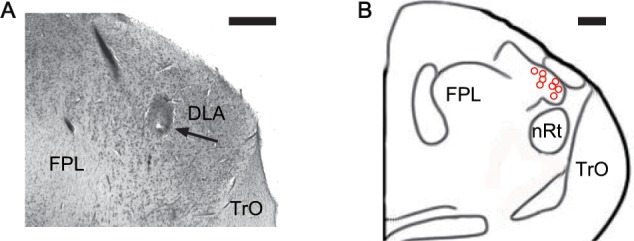
Histological identification and distribution of recording sites marked with electrolytic lesions.(A) Recorded cells were marked by electrolytic lesions and identified within the rostral DLA. These histological marks validated the stereotaxic coordinates of the DLA recording sites. Brain section shows a recording site marked with a lesion (arrow) in the DLA at A7.00. (B) Schematic drawings of brain sections show the distributions of recording sites (red cycles) in the DLA (A6.25 to 7.25, L2.80 to 3.80, H7.00 to 8.00) (Karten and Hodos, 1967). Abbreviations: FPL, fasciculus prosencephali lateralis; nRt, nucleus rotundus; TrO, tractus opticus. Scale bars: 0.50 mm in (A) and 0.50 mm in (B).